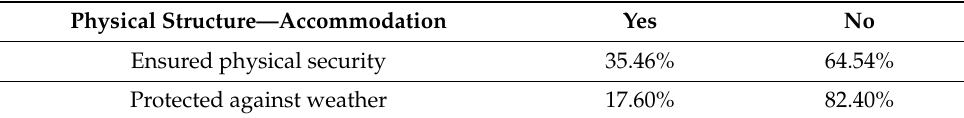
Table 3. Conditions of the accommodations’ physical structure. Physical